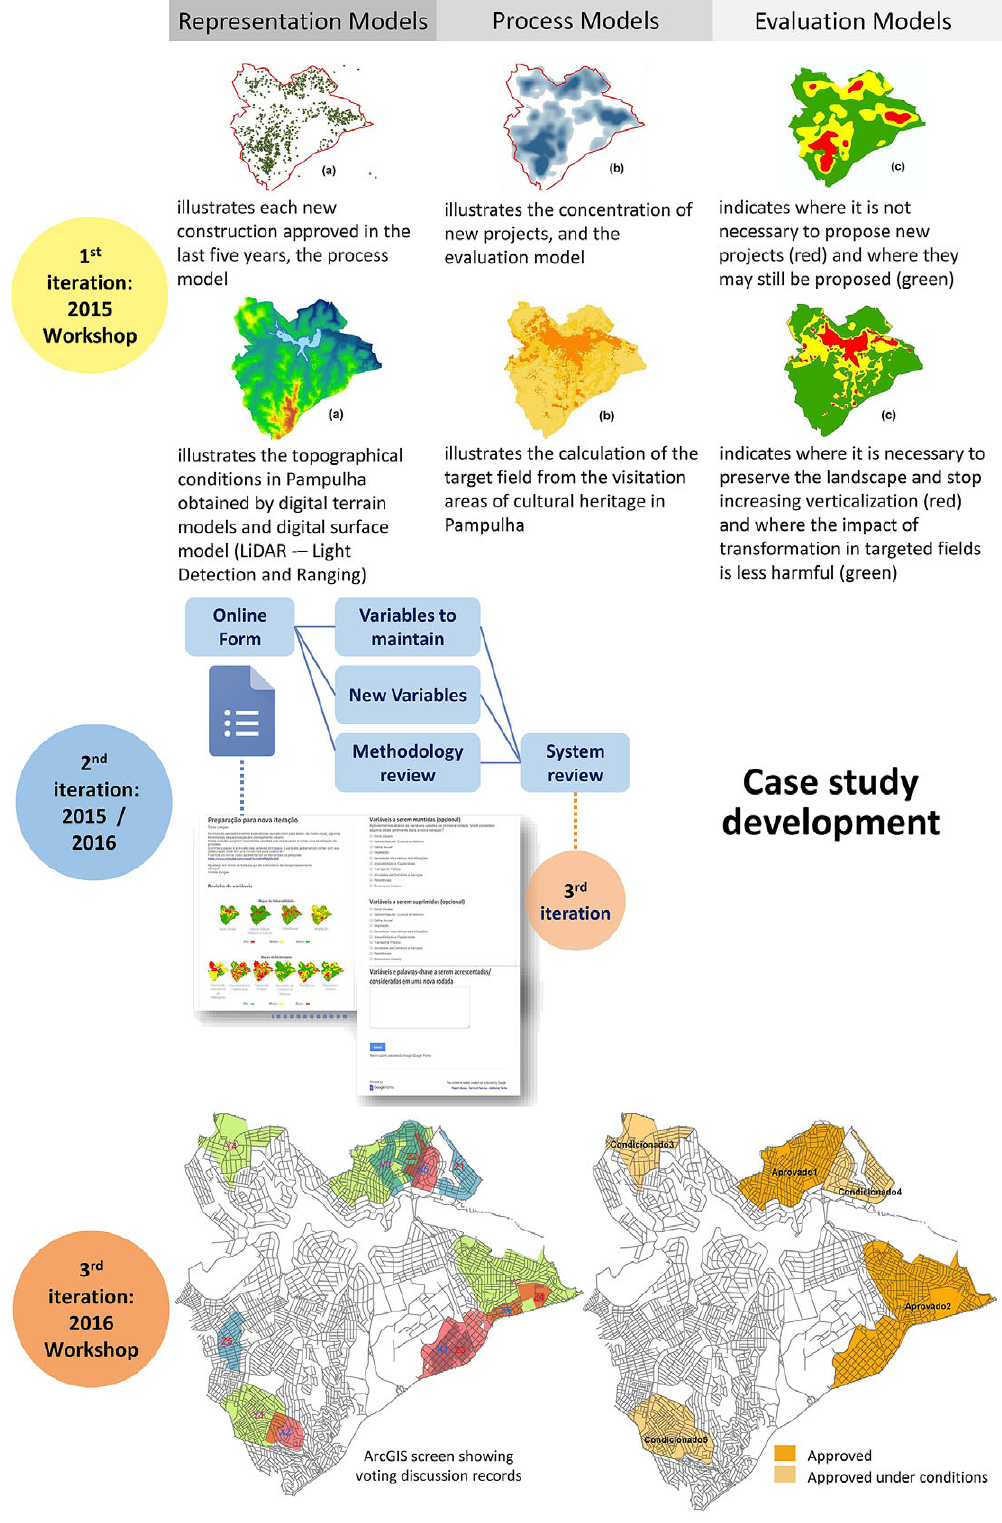
Fig. 10. The composition of three Geodesign iterations in the case study of Pampulha. Each iteration involves working with representation, process, and evaluation models resulting in the production of data, information, and knowledge, respectively. Following the account of the existing conditions, the proposal stage begins, which is related to change, impact and decision models that also produce data, information and knowledge, respectively (by A.C. Moura et